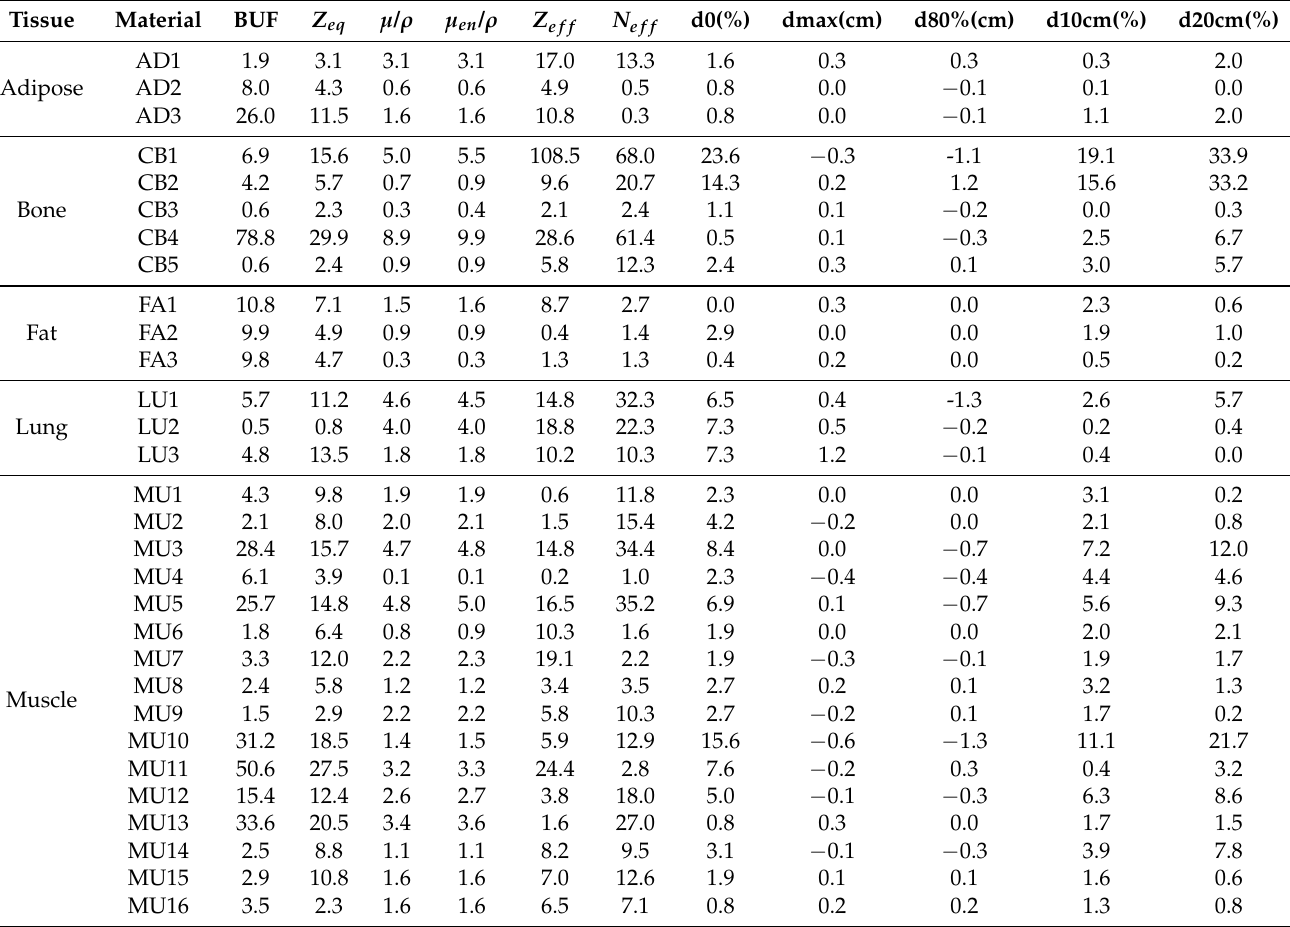
Table 3. Relative difference between tissues and mimicking material candidate properties in % for BUF, Z eq , µ / ρ , µ en / ρ , Z ef f , N ef f , d0 and dmax and in cm for d80, d10cm and d20cm. Here, d0, dmax, d80, d10cm and d20cm are represented as the superficial, maximum, 80% of the maximum, and depth of 10 cm and 20 cm adsorbed dose,